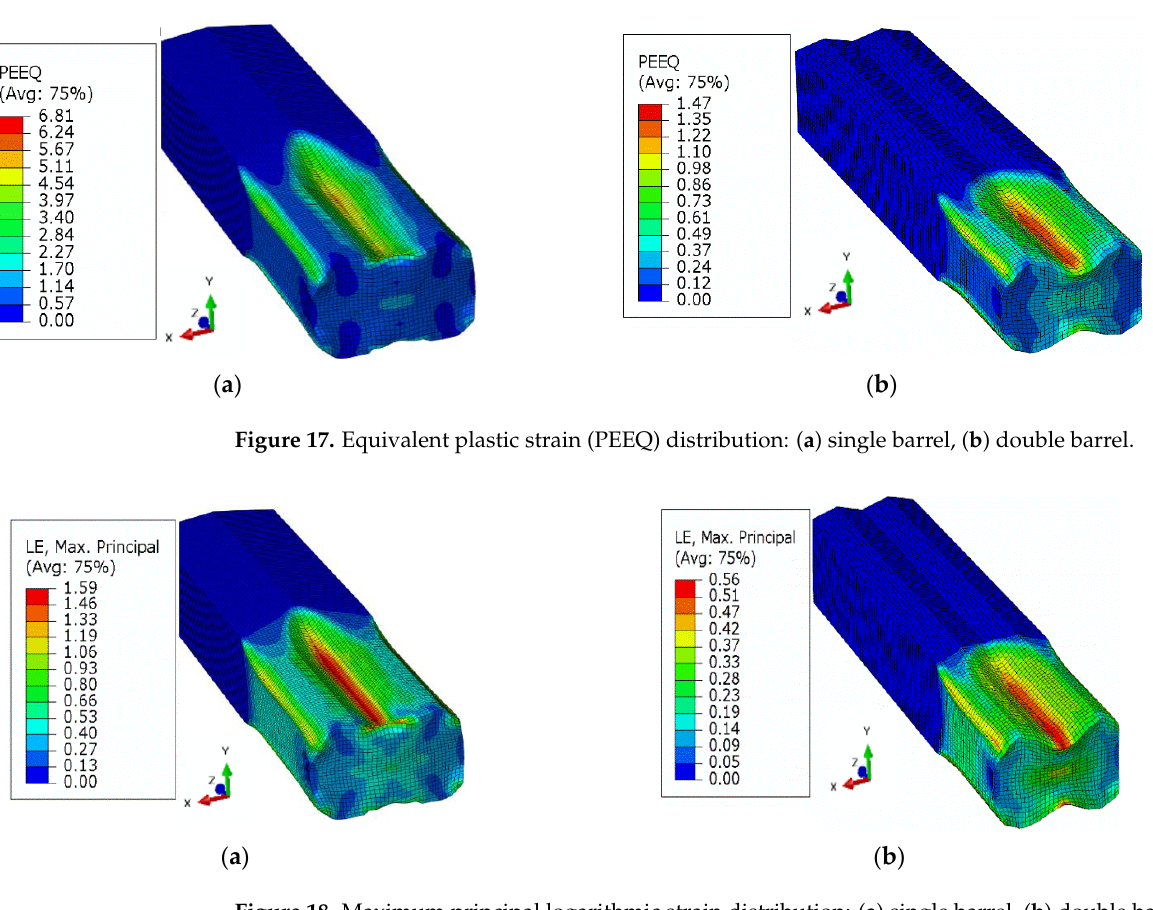
Figure 16. Von Mises stress distribution: ( a ) single barrel, ( b ) double barrel.